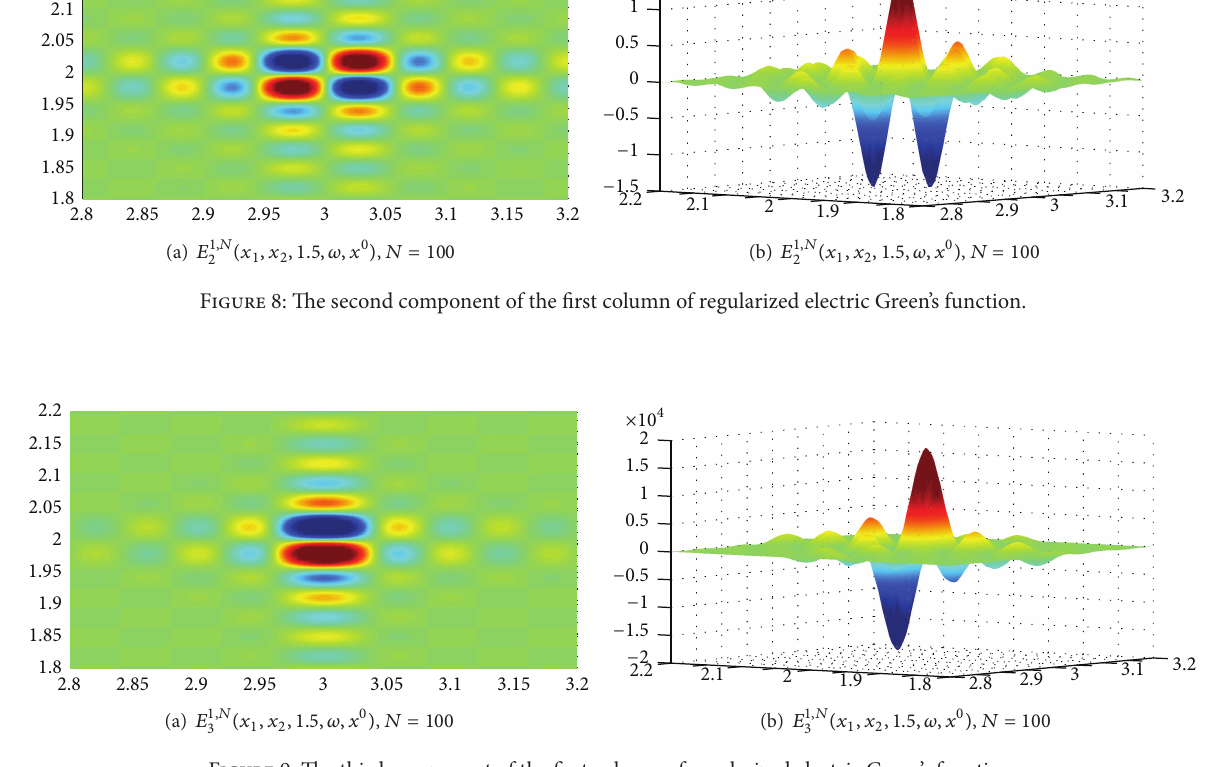
Figure 9: The third component of the first column of regularized electric Green’s